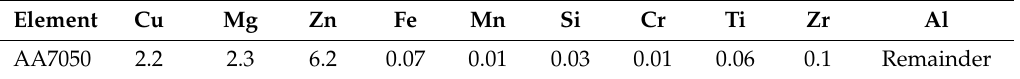
Table 1. Chemical composition of AA7050-T7451 (wt %).